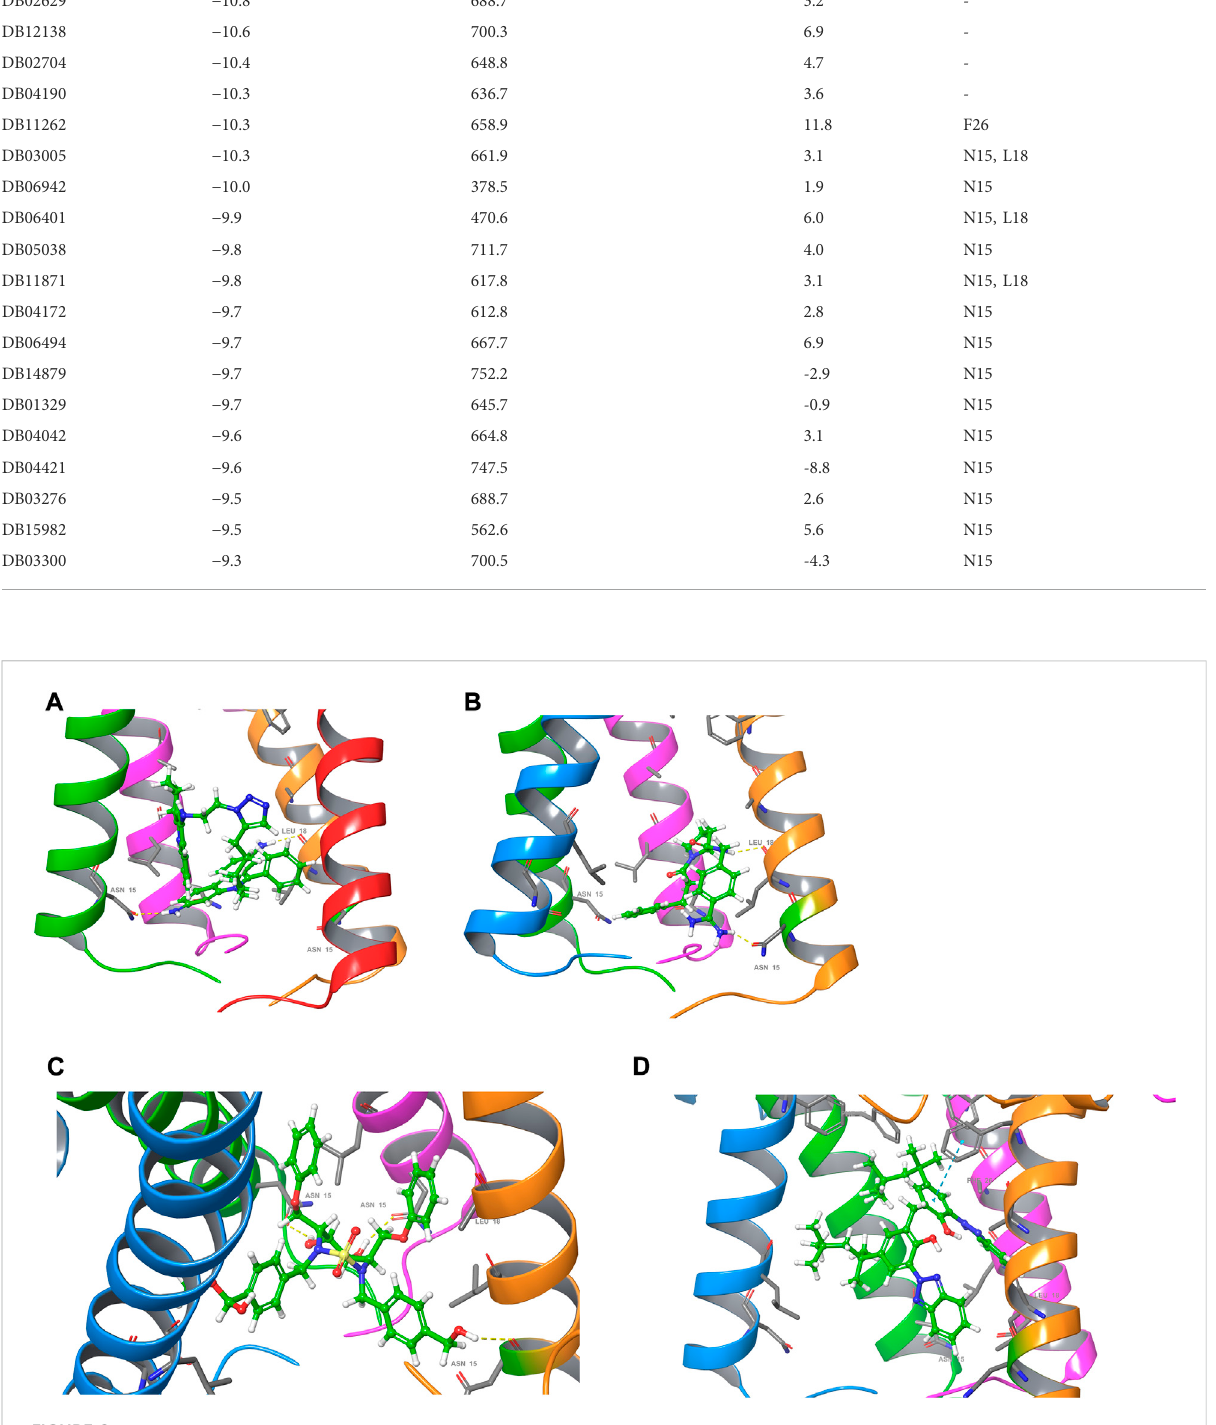
FIGURE 8 Docking poses of (A) DB03005, (B) DB06942, (C) DB04042 and (D) DB11262. For clarity, one of the chains of the E protein is not